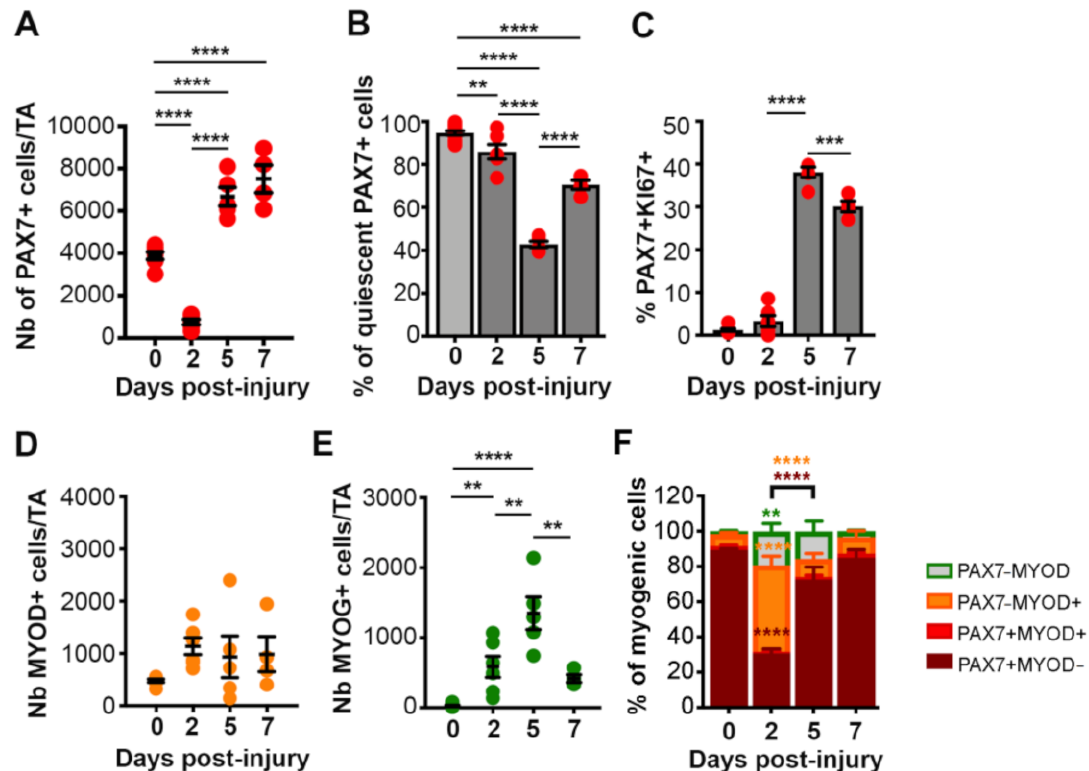
Figure 4. Quantitative FACS analysis of mononucleated cells from single TAs. Graphs showing the number of PAX7+ cells/TA ( A ), the % of quiescent PAX7+ cells (defined as MYOG − MYOD − Ki67 − PAX7+ cells) ( B ), the % of KI67+PAX7+ cells ( C ), the number of MYOD+ cells/TA ( D ) and MYOG+ cells/TA ( E ), and the proportions of myogenic cells expressing PAX7 and MYOD ( F ). Data are represented as the mean ± sem of minimum 4 isolated TAs. One-way ANOVA or Two-way ANOVA ( F ) with ** p < 0.01, *** p < 0.001 and **** p <